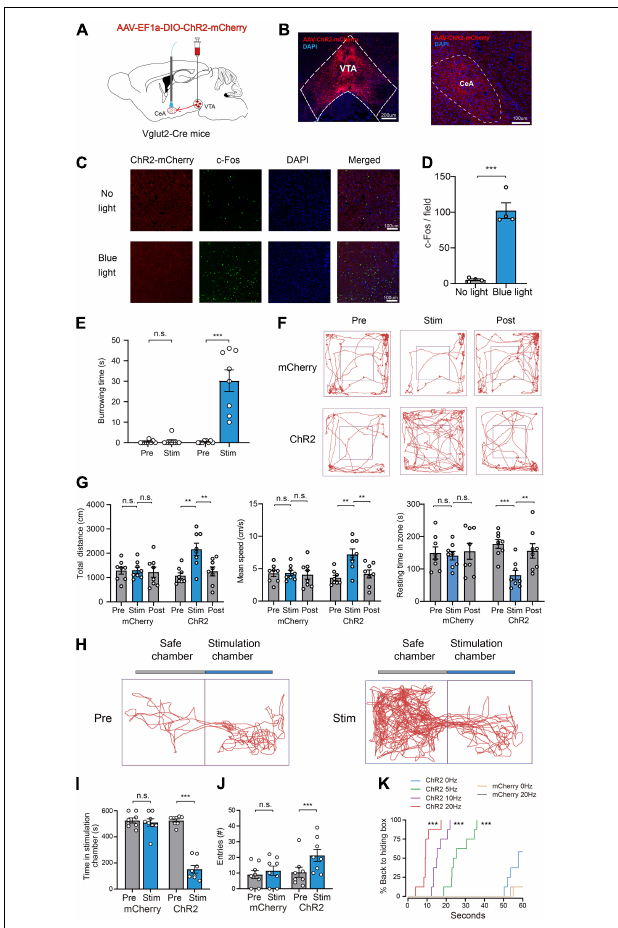
FIGURE 4 | Photoactivation of glutamatergic VTA-CeA pathway promotes defensive behaviors. (A) Schematic of AAV-EF1a-DIO-ChR2-mCherry expression in the VTA and fiber implantation in the CeA for photostimulation. (B) Fluorescent images showing glutamatergic ChR2-mCherry SOMA in the VTA (left) and terminals projecting to the CeA (right). Scale bar represents 200 and 100 µ m. (C,D) c-Fos expression in the CeA without (top) or with (bottom) light stimulation. ( n = 4, 8 sections for each group. two-tailed unpaired t -test; t 6 = 8.817, P < 0.001). Scale bars represent 100 µ m. (E) Burrowing duration upon stimulation of the glutamatergic VTA-CeA pathway in the home cage [ n = 8 ChR2 vs. n = 8 mCherry; two-way repeated-measures ANOVA, virus × stimulation, F (1,14) = 31.26, P < 0.001, Bonferroni post hoc comparison]. (F) Examples of tracking traces of mice in open field tests. (G) Photostimulation of the glutamatergic VTA-CeA pathway influenced total distance, mean speed and resting time in open field experiments [ n = 8 ChR2 vs. n = 8 mCherry; two-way repeated-measures ANOVA, virus × stimulation, F (2,28) = 6.727, P = 0.0041, F (2,28) = 6.716, P = 0.0041, F (2,28) = 4.442, P = 0.0211, Bonferroni post hoc comparison]. (H) Example trajectories of mice in RTPP tests. (I,J) Photostimulation of glutamatergic VTA-CeA pathway influenced the stimulation chamber staying time and safe chamber entries of mice in the RTPP experiment. [ n = 8 ChR2 vs. n = 8 mCherry; two-way repeated-measures ANOVA, virus × stimulation, F (1,14) = 82.24, P <